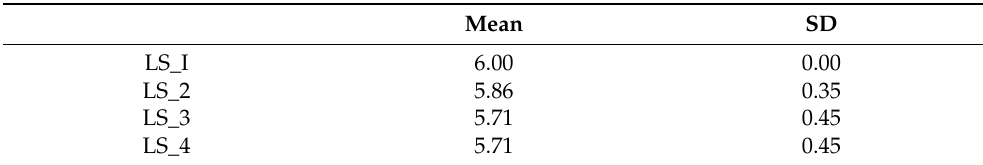
Table 1. Ability to emulsify fatty soils of tested soaps ((LS I − base; in following soaps, addition of 4% ( w/w ) surfactants: LS II − cocamidopropyl betaine; LS III − addition of cocamidopropyl